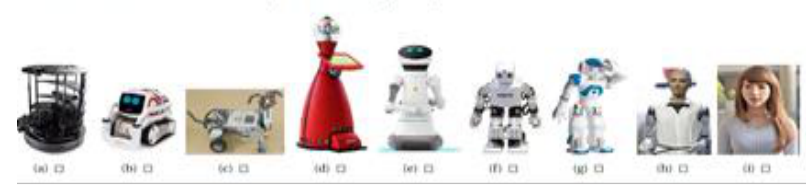
Fig. 3. Question on different robot types